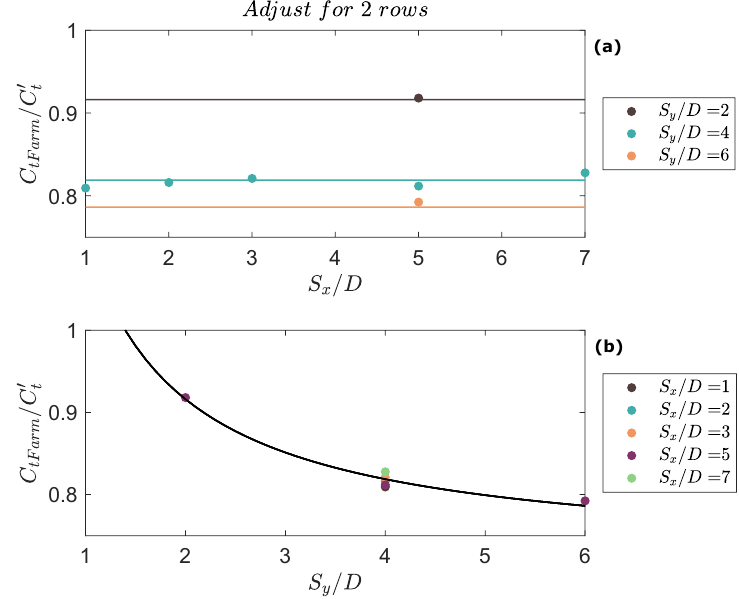
Figure 9. C tFarm / C ′ t , for farms with exactly two rows of turbines, versus the disk separation in: ( a ) the streamwise direction, and ( b ) in the spanwise direction. Continuous line: Empirical solution proposed in Equation (9). Dots: Results from DES numerical simulations.